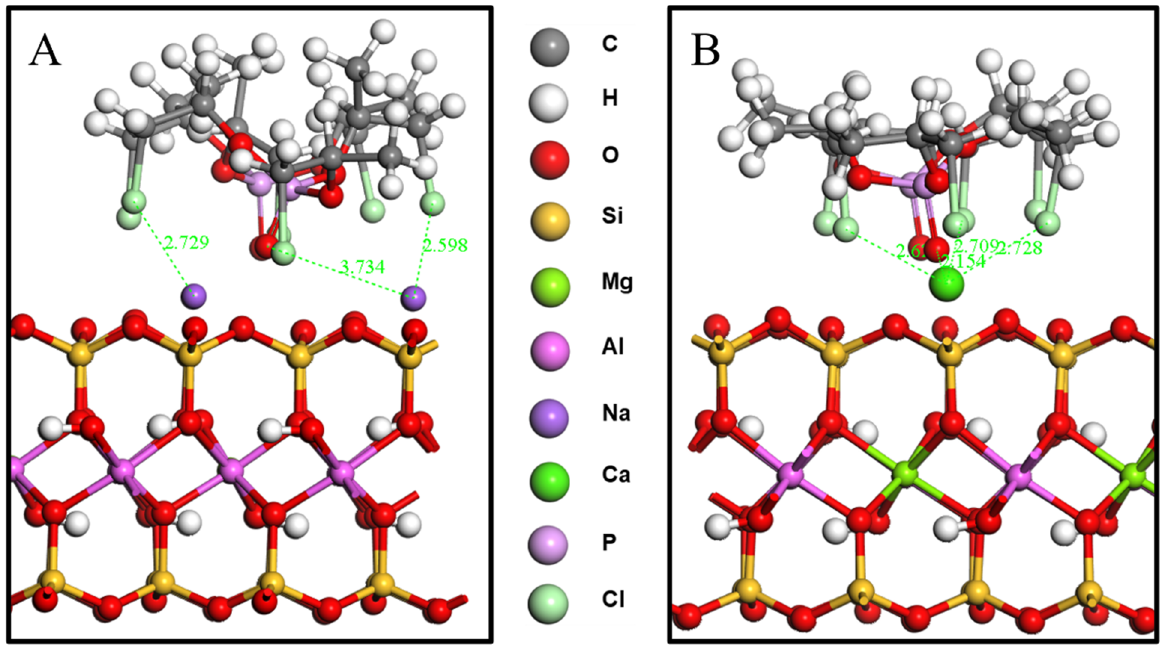
Figure 4. Close range annotation between molecules. ( A ) TCPP/NaMMT model; ( B ) TCPP/CaMMT model.